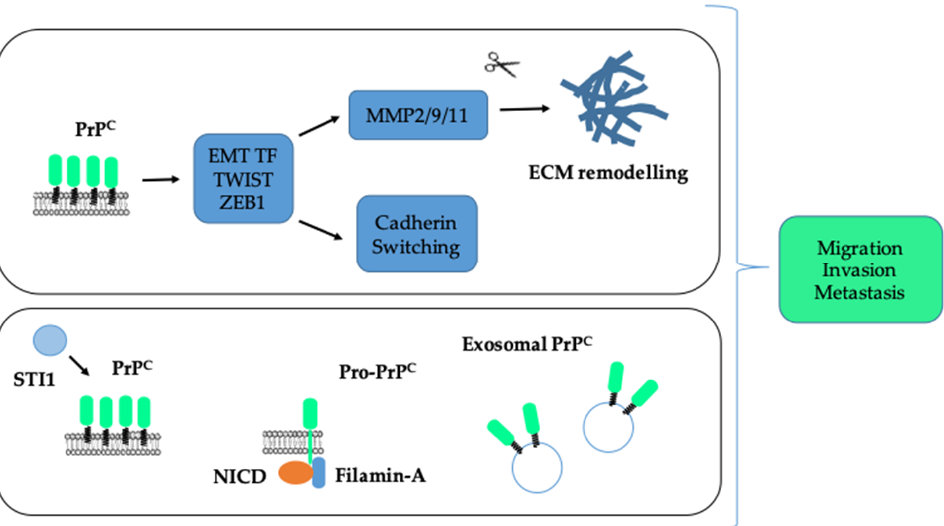
Figure 4. Elevated PrP C is associated with increased invasion and migration of cancer cells and metastasis. PrP C promotes an upregulation of EMT transcription factors (EMT TF), a switch from E-cadherin to N-cadherin expression as well as an induction of matrix metalloproteases, themselves fostering the remodelling of the extracellular matrix (ECM) (top panel). This action may be fostered by the interaction between PrP C and its ligand STI1. It is also supported by pro-PrP C , through its interaction with Filamin-A and the active cleaved fragment of Notch, NICD (Notch Intra Cellular Domain) or by exosomal PrP C (bottom